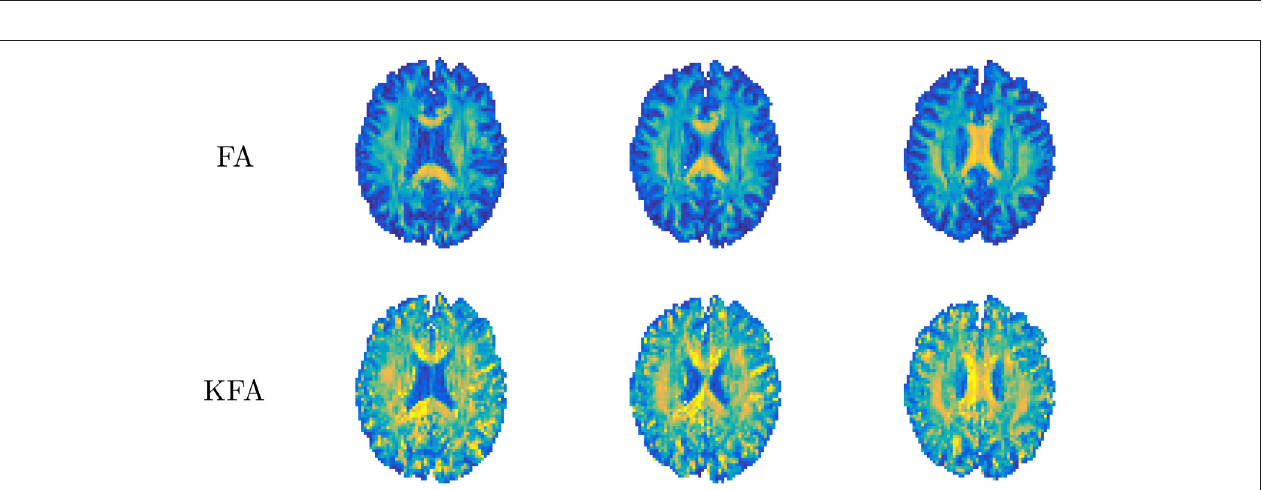
FIGURE 7 | Plots of diffusion time dependence for dispersion (A) and intra-axonal diffusivity ( D a , B ) in both of the two WMTI solution branches (labeled Data points are color coded to four ROIs in the pig spinal cord used for this experiment. The ROIs are labeled A, C, E, G in keeping with Jespersen et al. [ 73] where the data was first presented. Figure adapted from Jespersen et al. [73] with permission.